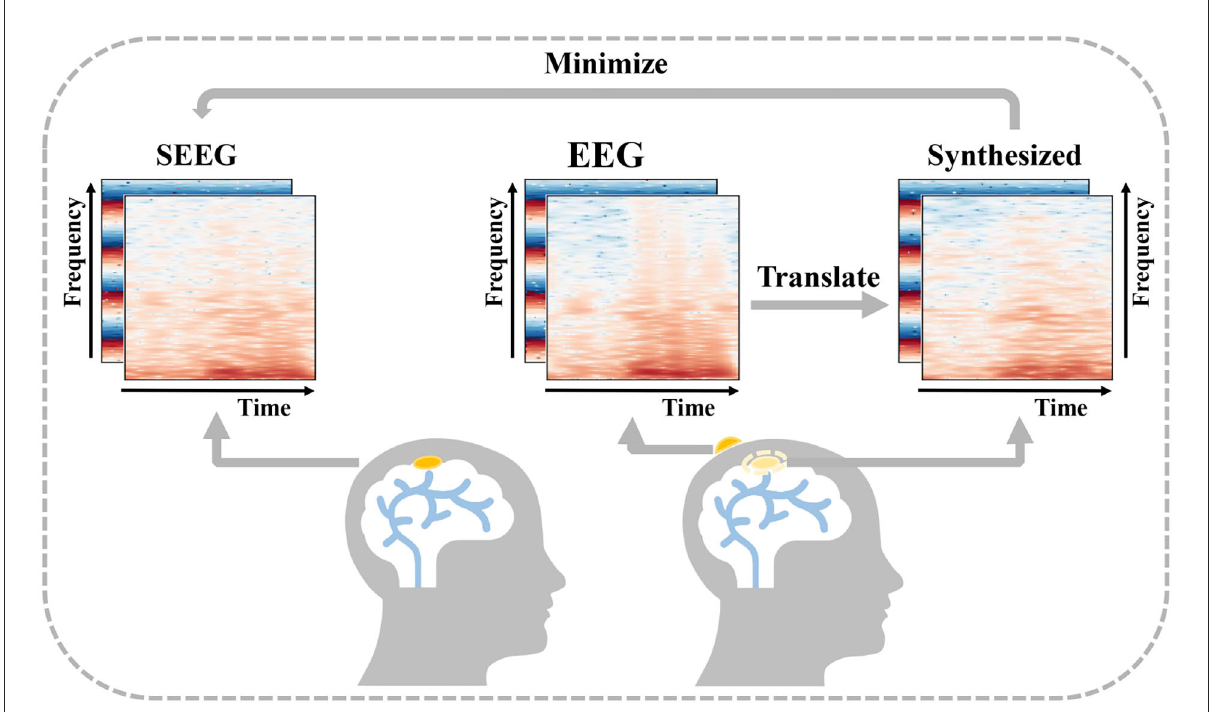
FIGURE1 Description of EEG-to-Stereoelectroencephalography (SEEG) translation. EEG and SEEG are represented with a concatenated matrix of frequency and IF spectra. The difference between the real invasive SEEG and that synthesized from simultaneous non-invasive EEG is